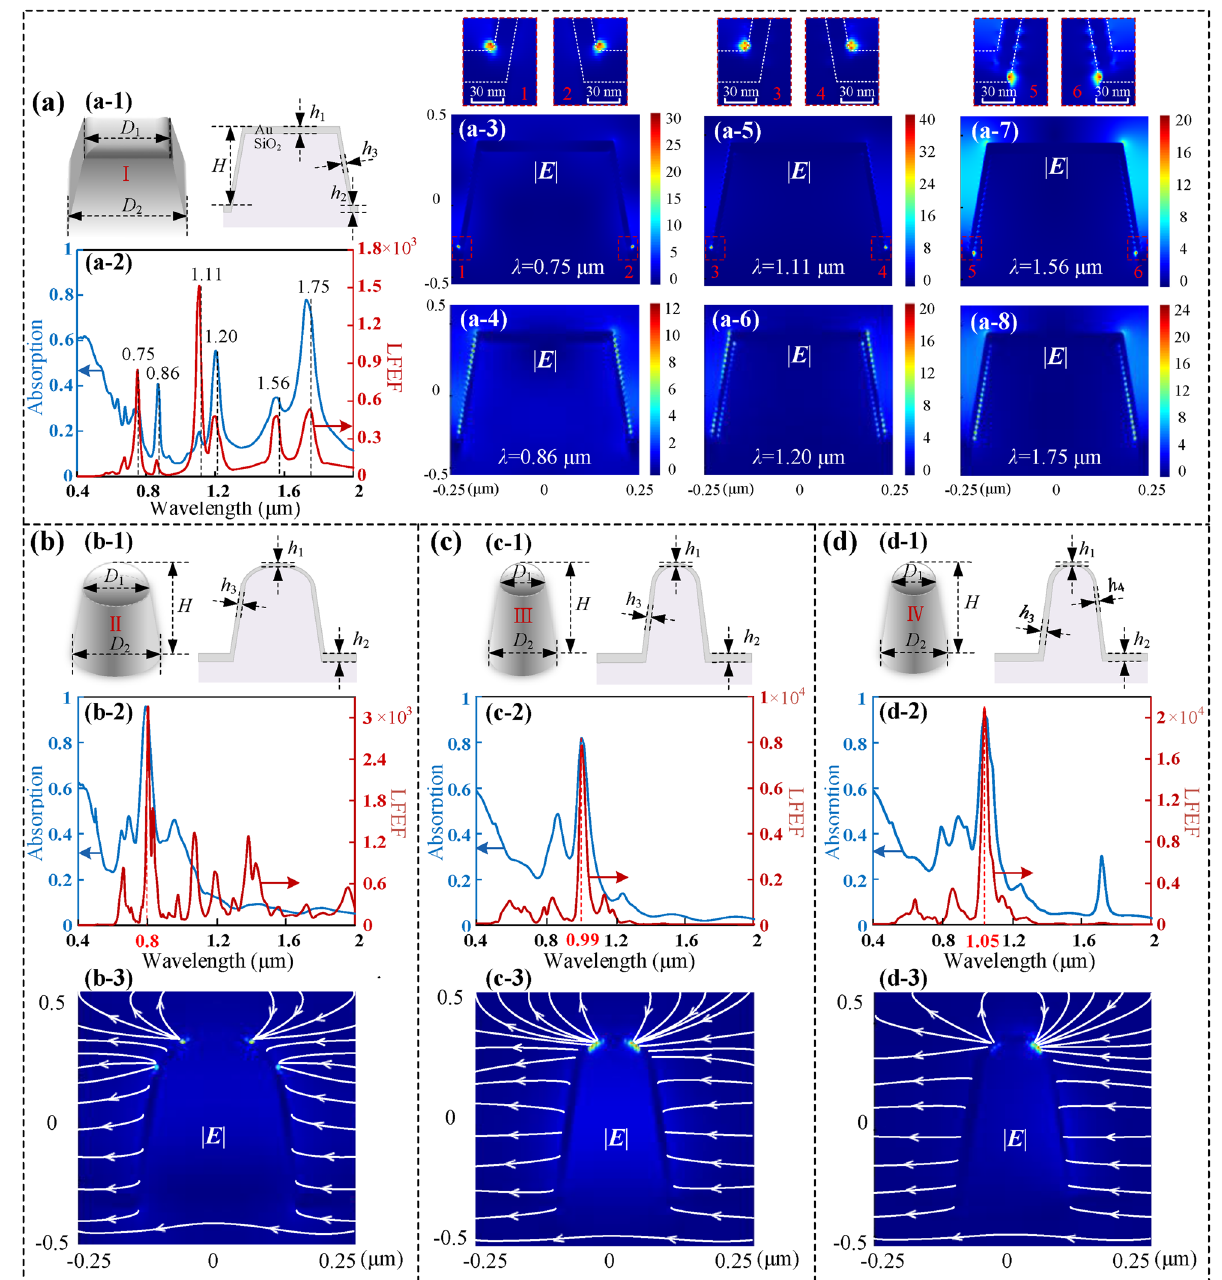
Figure 1. Simulations of the GGNCTs with the lightbeams in a wavelength range of 0.4–2 μm and illuminating normally from the bottom. ( a ) The main simulation results of GGNCT-I. ( a-1 ) Two-layered SiO 2 and metal films with critical parameters. The top and bottom side lengths are D 1 = 375 nm and D 2 = 460 nm, and the height H = 300 nm. The thicknesses of the gold film at the top and bottom are h 1 = h 2 = 30 nm and at the sidewalls h 3 = 15 nm. ( a-2 ) The LFEF and the light absorption curves. ( a-3 )–( a-8 ) The | E| cross-sectional profiles of several light wavelengths are selected. The enlarged views of the strong near-field convergence spot demonstrated in ( a- 3 ), ( a-5 ), and ( a-7 ), are inserted above the corresponding figures. ( b – d ) Structural parameters and simulations for a single GGNCT with a large base area ( b ), and a small base area ( c ), and an asymmetrical metal coating ( d ). Structural parameters for ( b-1 ): The top and bottom diameters are D 1 = 215 nm and D 2 = 300 nm, and the height H = 300 nm. The thicknesses of the gold film at the top and bottom are h 1 = 10 nm and h 2 = 30 nm, and at the sidewalls h 3 = 15 nm; Structural parameters for ( c-1 ): The top and bottom diameters are D 1 = 145 nm and D 2 = 225 nm, and the height H = 300 nm. The thicknesses of the gold film at the top and bottom are h 1 = 10 nm and h 2 = 30 nm, and at the sidewalls h 3 = 15 nm; Structural parameters for ( d-1 ): The top and bottom diameters are D 1 = 145 nm and D 2 = 225 nm, and the height H = 300 nm. The thicknesses of the gold film at the top and bottom are h 1 = 10 nm and h 2 = 30 nm, and at the left and right sidewalls h 3 = 20 nm and h 4 = 10 nm. ( b-2 )–( d- 2 ) The LFEF and the light absorption curves, and ( b-3 )–( d-3 ) show the typical E -field distributions at the resonance wavelengths. The instantaneous E -field directions are represented by white